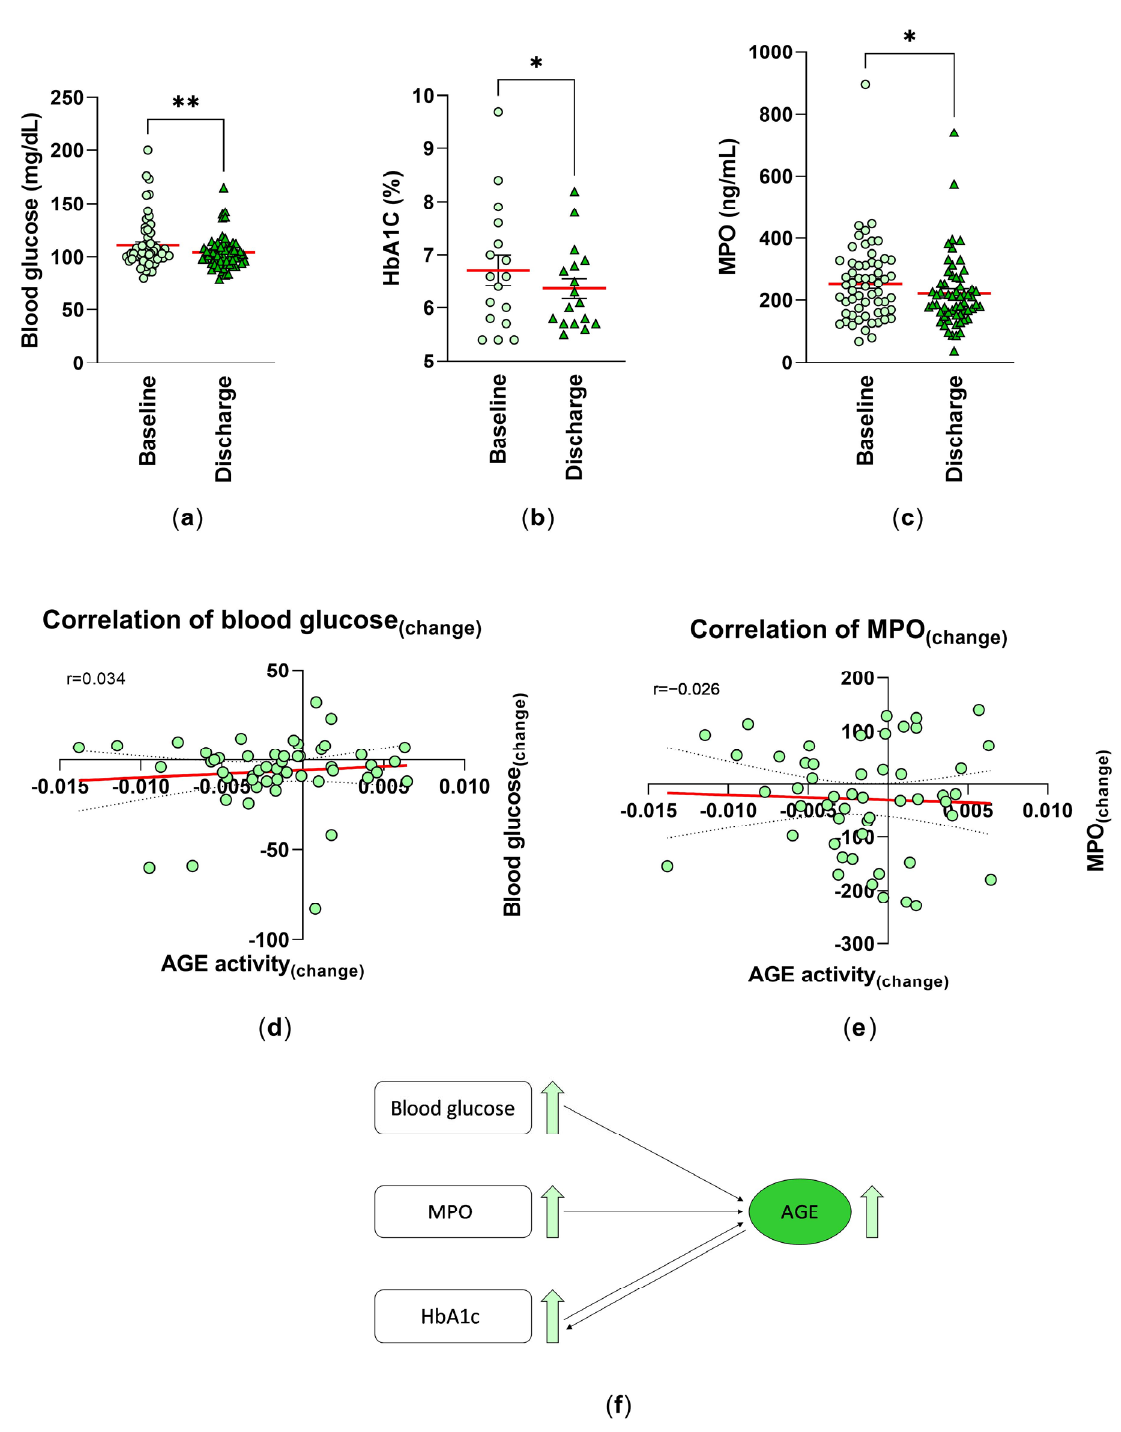
Figure 3. Analysis of the risk factors for cardiovascular diseases: the blood levels of ( a ) glucose (mg/dL) (n = 58), ( b ) HbA1c (%) (n = 17) were measured as part of the routine blood analysis, and ( c ) the MPO levels of serum samples (ng/mL) (n = 59) were analyzed by ELISA technique at baseline (T 0 ) and discharge (T 1 ). Individual and mean values (red line) are shown. **: p < 0.01; *: p < 0.05. Spearman correlation (r) between the AGE activity (changes) and ( d ) blood glucose (changes) (n = 50) and ( e ) the MPO (changes) (T 1 − T 0 ) of the serum samples (n = 51) were analyzed. Simple linear regression is given (red line). ( f ) Schematic representation of the relationship between the CVD risk factors and serum levels of AGEs.